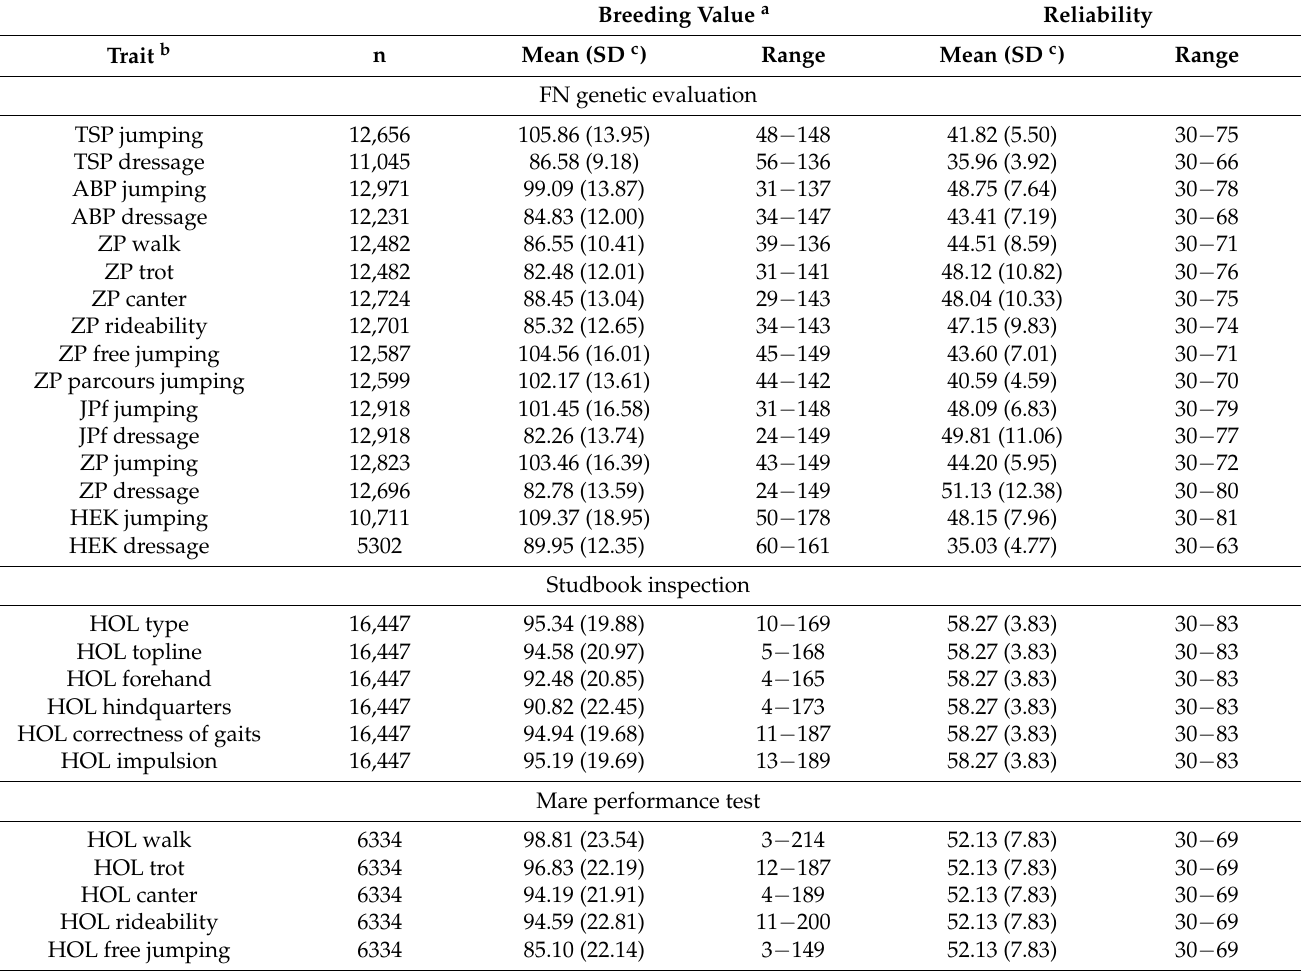
Table 2. Descriptive statistics of the breeding values and reliabilities estimated on behalf of the FN and on behalf of the Holstein Breeding Association for studbook inspection and mare performance test. Breeding Value